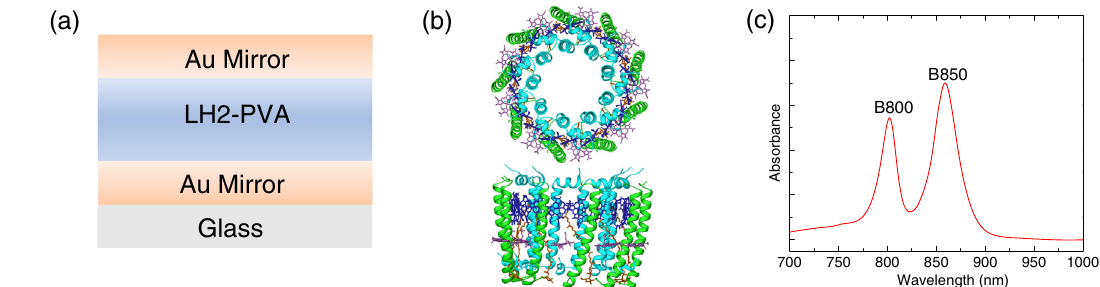
Fig. 1 | Microcavity structure and LH2 properties. a Structure of the semi- transparent Fabry – Pérot cavity, where two Au mirrors (thickness of 22nm) sand- wich a PVA fi lm containing LH2 (thickness of300nm); b structureofLH2 complex from Rhodoblastus acidophilus strain 10050 with a view normal to the membrane plane (top) and a side viewof the complex (down),where the closely packed B850